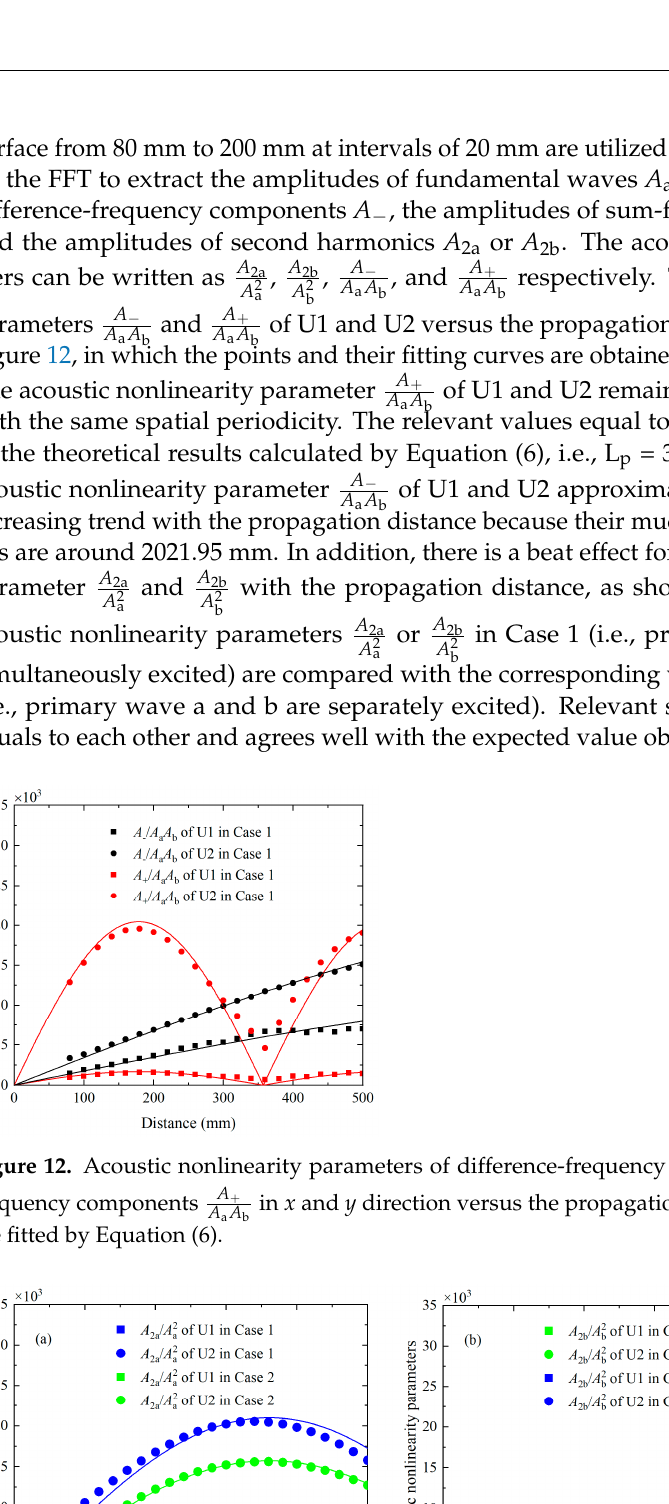
Figure 13. Acoustic nonlinearity parameters of second harmonics A 2a in Case 1 and Case 2 ( a ), as well as A 2b in Case 1 and Case 3 ( b ) as a function of propagation distance, which are also fitted by Equation (6).